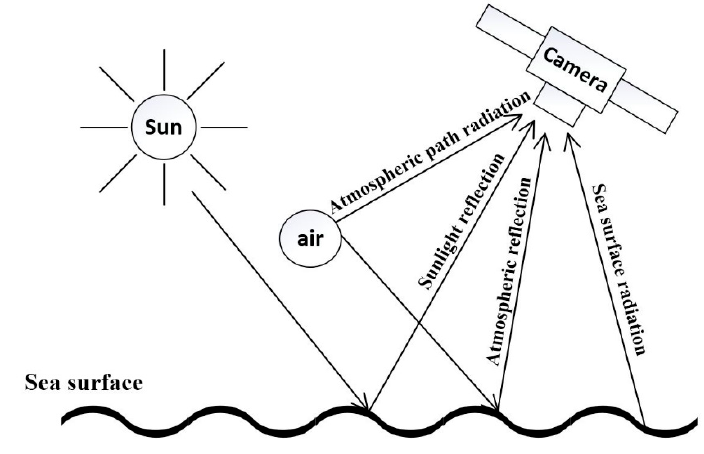
Figure 3. Ocean radiative transfer model.